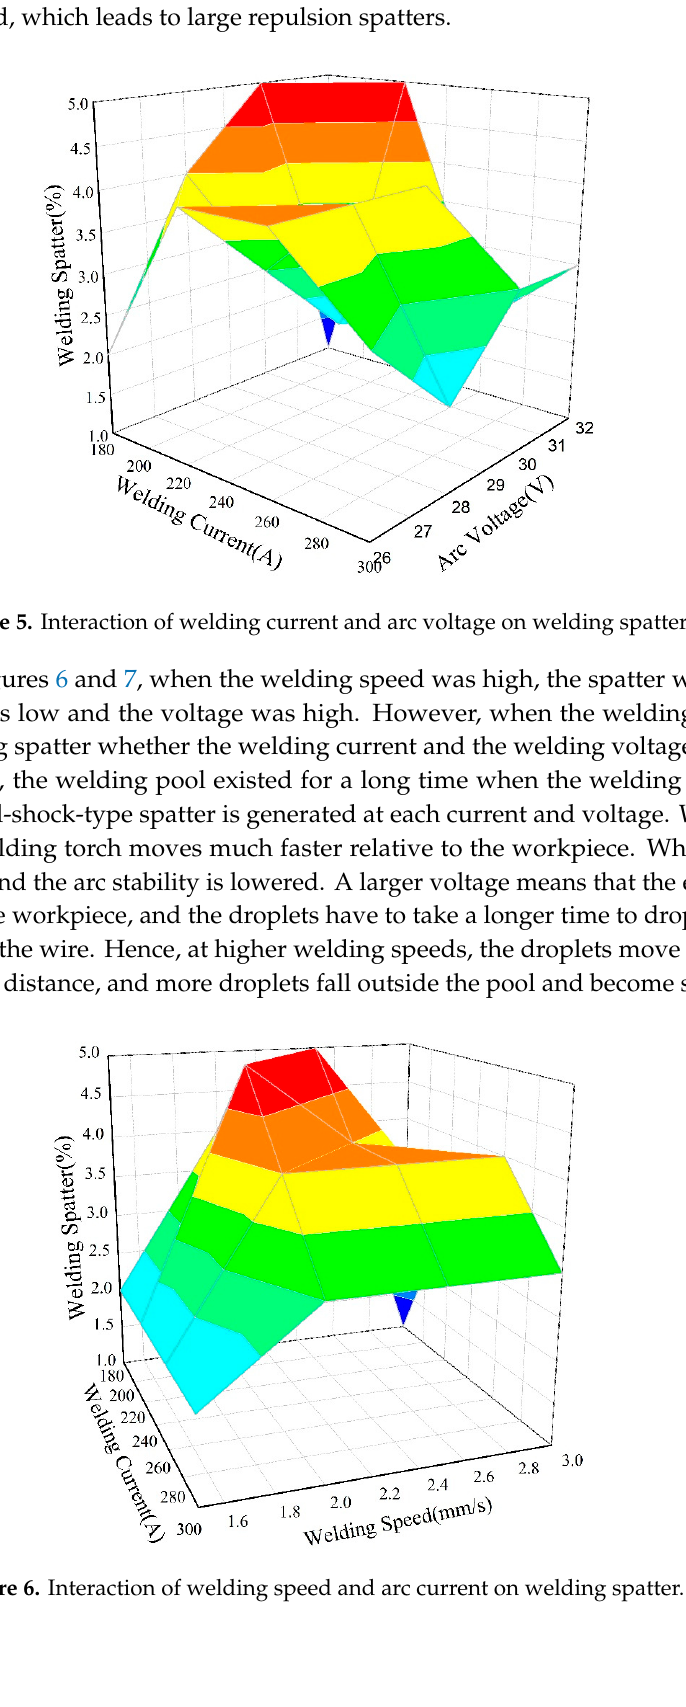
Figure 7. Interaction of welding speed and arc voltage on welding spatter. A smaller optimal range of each parameter was obtained through orthogonal test. On this basis, further tests were carried out, and finally the optimal parameters were obtained as shown in Table 4. Figure 8 shows the weld appearance under this welding parameter. Table 4. Optimal welding parameters. Welding Current Arc Voltage CTWD Welding Speed 200 A